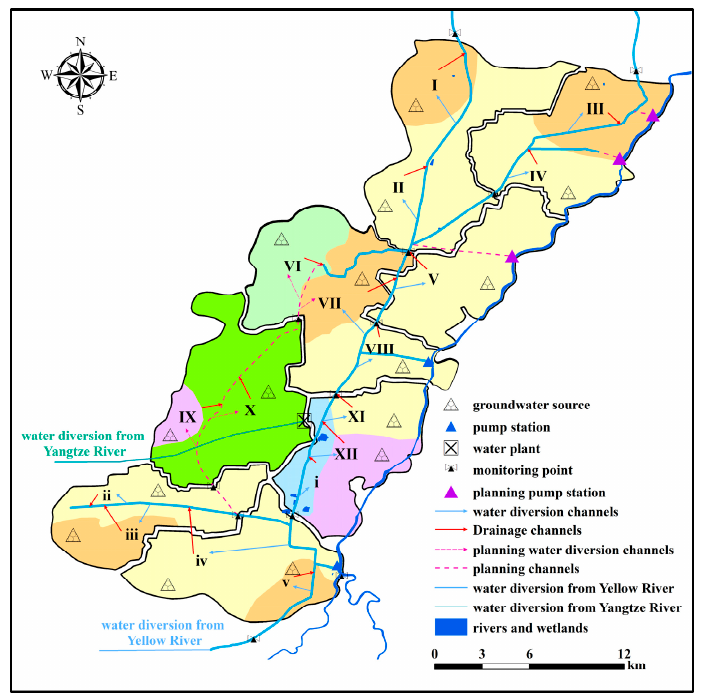
Figure 4. Water resources allocation system network diagram in Guantao County.